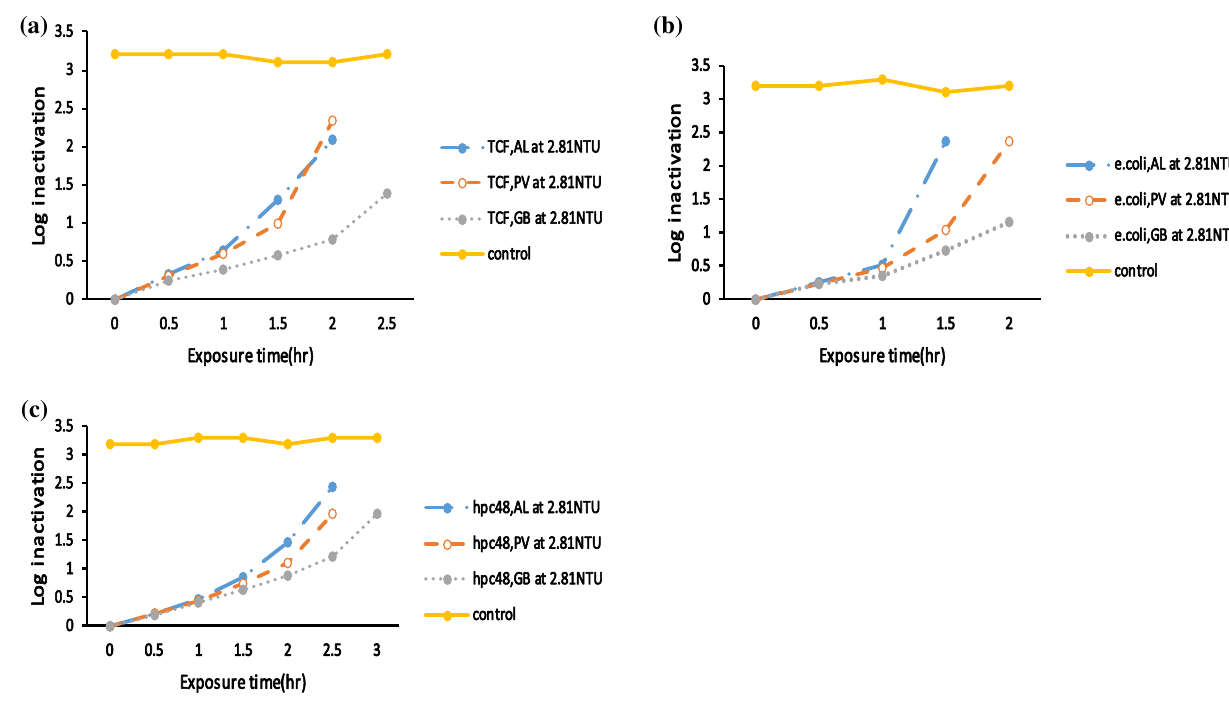
Fig. 3 Comparison of microbial inactivation between concentrators at 2.81 NTU turbidity level. a Comparison between concentrators for total coliform counts inactivation. b Comparison between concentra-